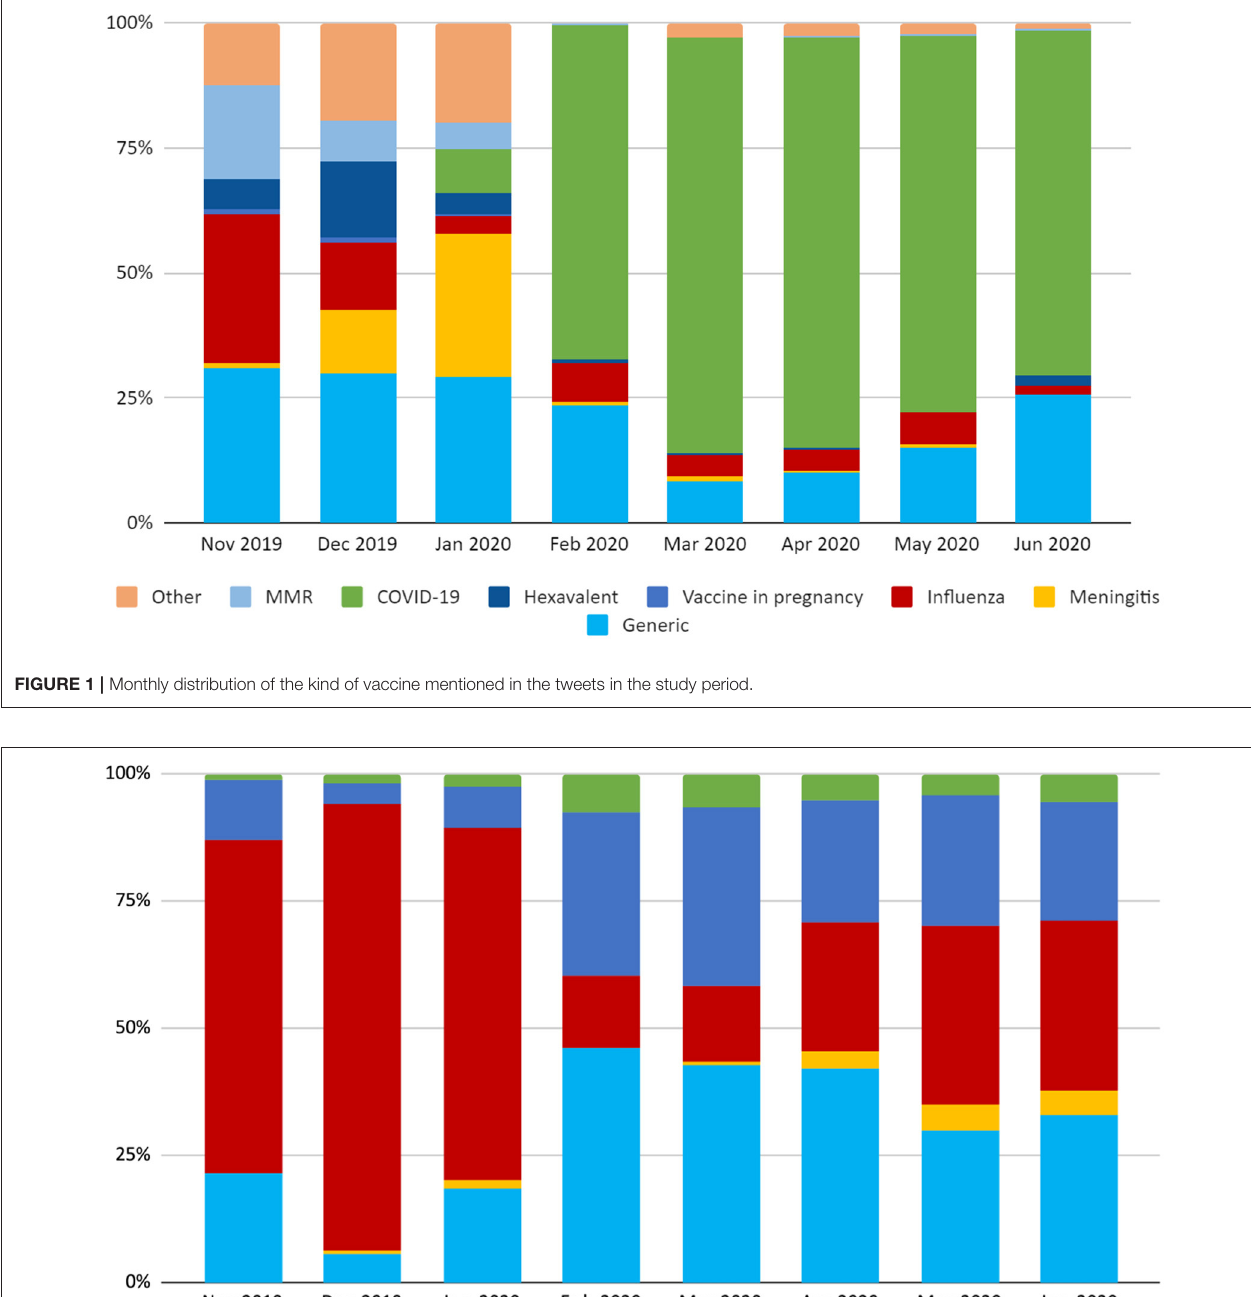
conspiracy and other topics. Some interesting differences emerge between discouraging and ambiguous